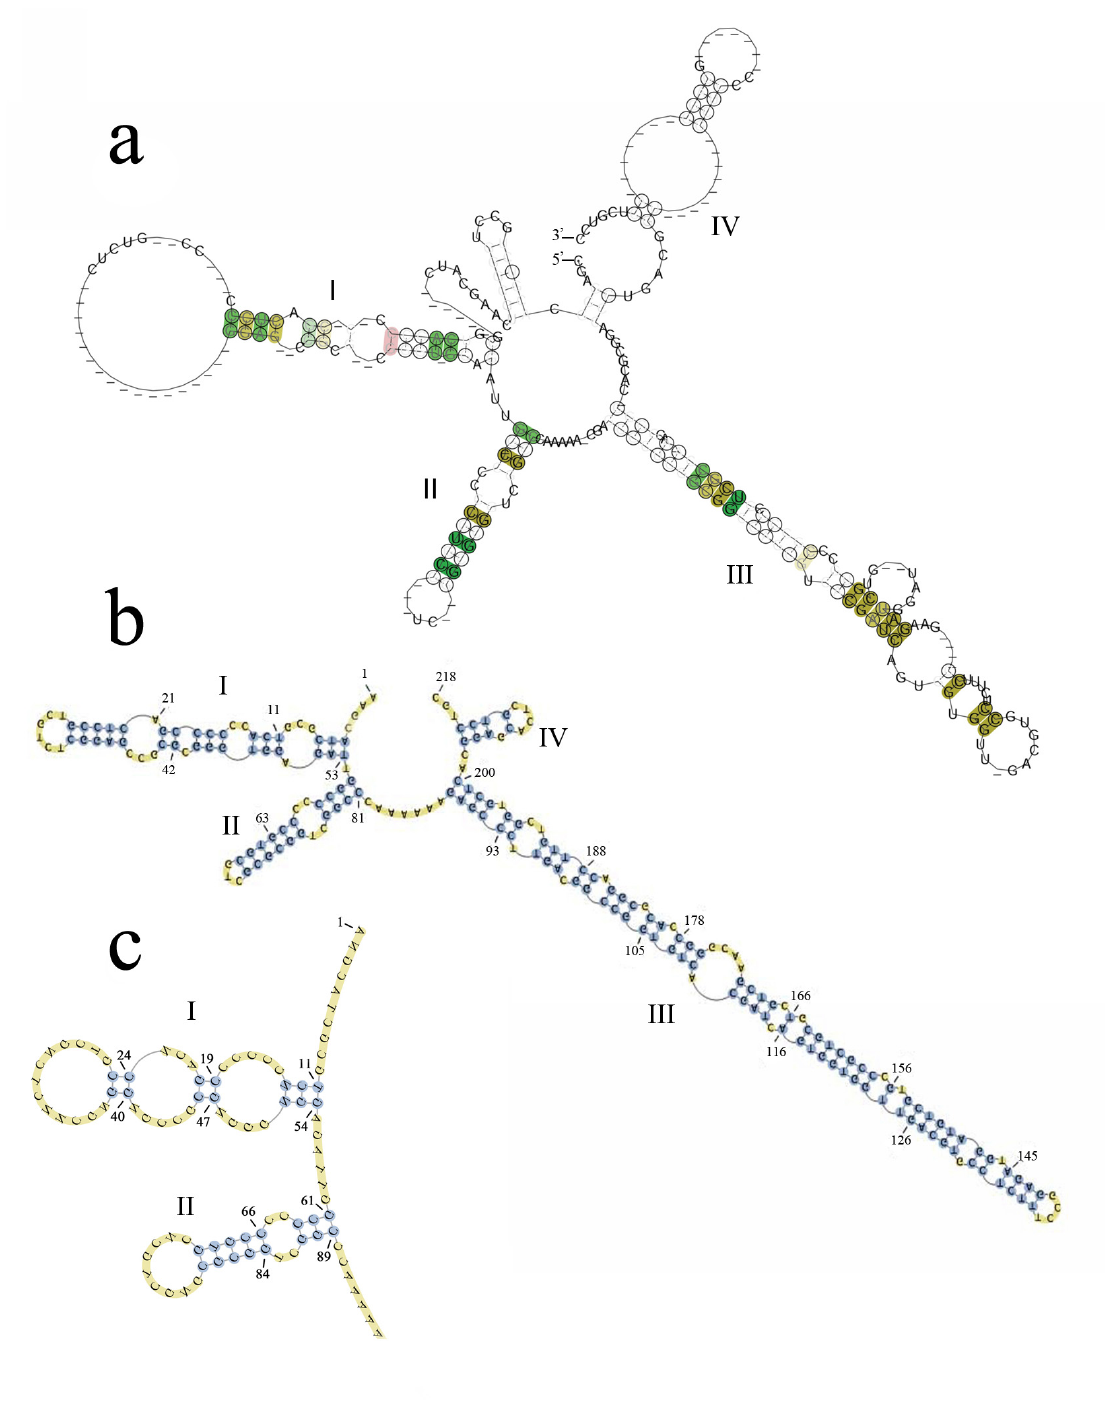
Fig 1. The predicted ITS2 secondary structure of the “ Mu tong ” taxa. (a) Consensus secondary structure model of the ITS2 region based on 30 sequences covering four families (Actinidiaceae, Aristolochiaceae, Lardizabalaceae and Ranunculaceae). The four helices, each with a stem – loop, are labeled I – IV. Compatible base pairs are colored and the degree of conservation over the whole alignment is indicated with different degrees of color saturation. (b) One of the example secondary structures of Akebia quinata . (c) The position of the strictly conserved base pair sites (highlight in blue circle) found in the 70% consensus ITS2 secondary structure